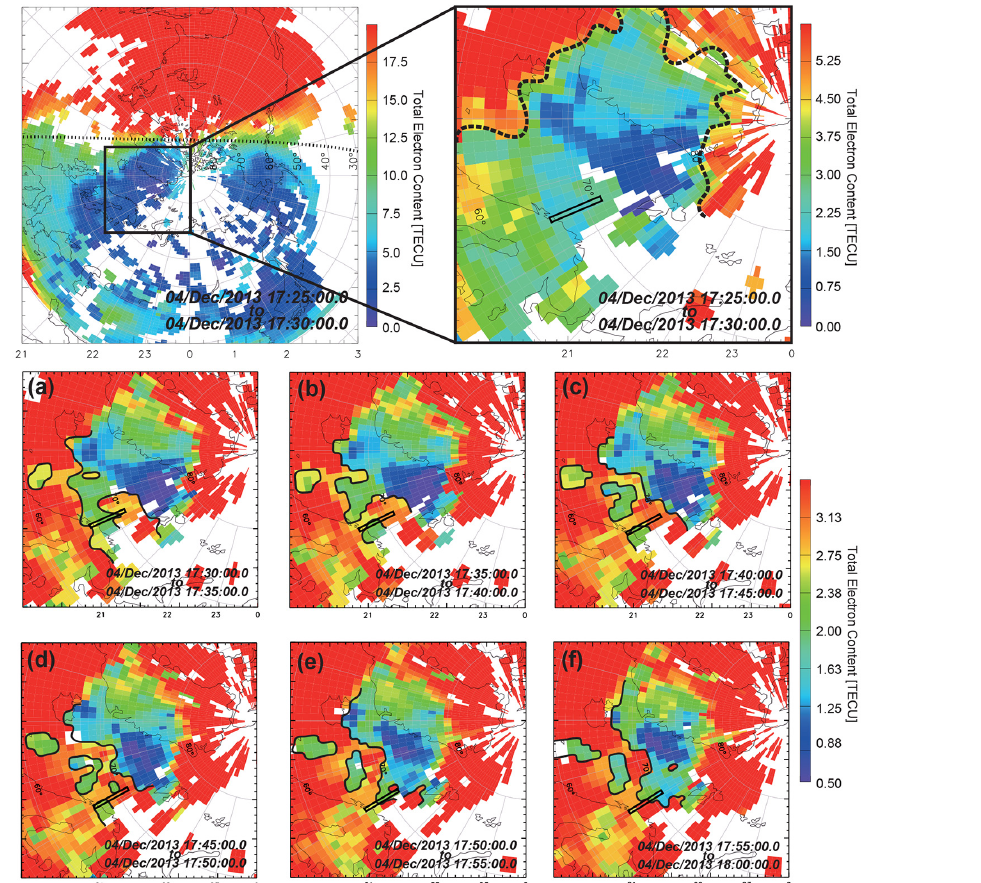
Figure 1. The TEC map after onset of the substorm. The top left panel is an overview of the polar ionosphere around onset time, and the top right panel enlarges the black box shown in the top left panel; these data represent the TEC variation around the EISCAT FOV. The color scale runs from high-electron density (red) to low-electron density (blue). The dashed black line in the top left panel represents the solar terminator, where SZA = 90 ◦ . The black rectangle in the top right panel indicates the EISCAT FOV, and the dashed curving line indicates the boundary of the high-latitude trough. (a–f) indicate a time sequence of the horizontal shape of the density structures around the EISCAT FOV. The median filter was applied to each TEC